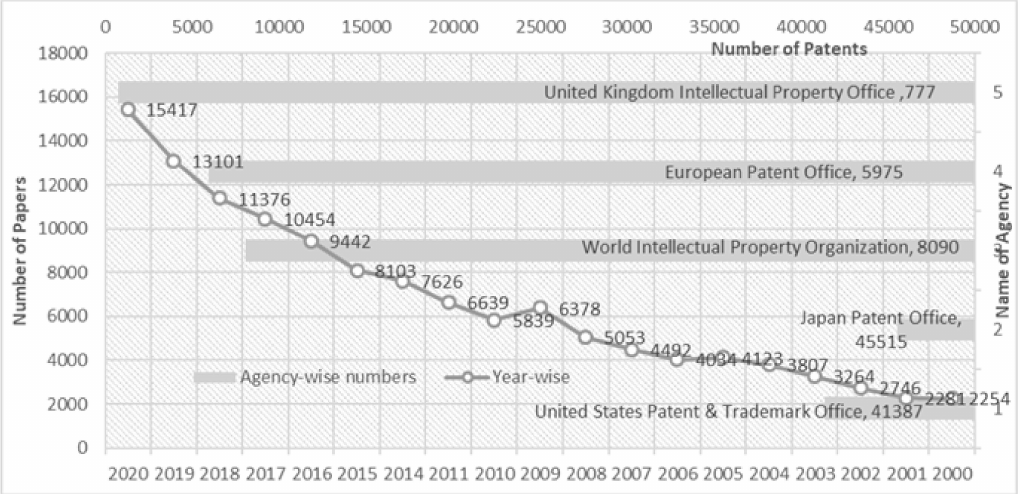
Figure 1. Number of research papers and patents available on the use of various materials for wastewater treatment per year from 2000 to 2020 from Scopus with the keywords “wastewater